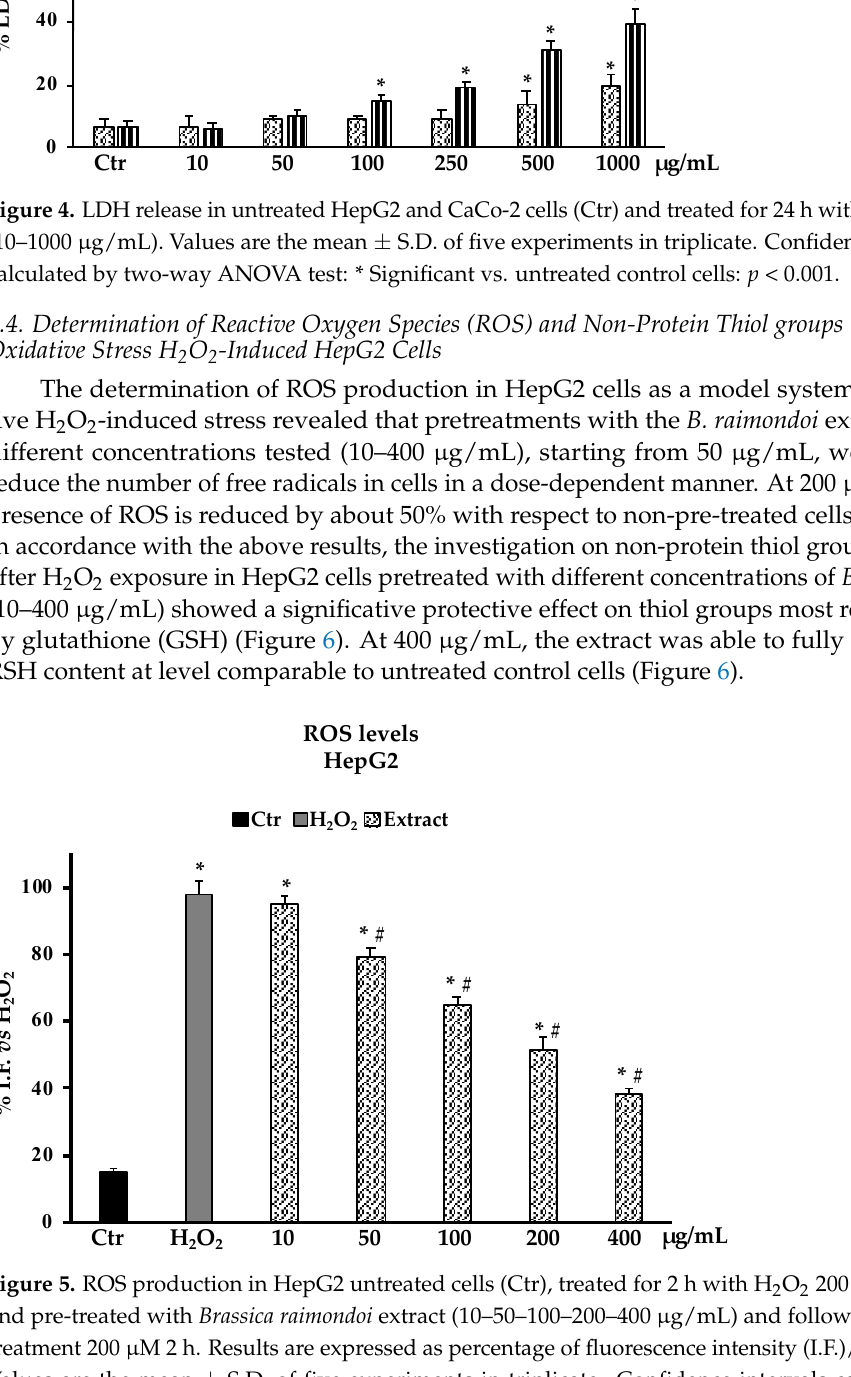
Figure 5. ROS production in HepG2 untreated cells (Ctr), treated for 2 h with H 2 O 2 200 μM (H 2 O 2 ), and pre-treated with Brassica raimondoi extract (10 – 50 – 100 – 200 –400 μg/mL) and followed by H 2 O 2 treatment 200 μM 2 h. Results are expressed as percentage of fluorescence intensity (I.F.)/mg protein. Values are the mean + S.D. of five experiments in triplicate. Confidence intervals calculated by two- way ANOVA test: * Significant vs. untreated control cells: p < 0.001; # Significant vs. H 2 O 2 treated cells: p < 0.001. I.F. vs. H 2 O 2 .: Intensity of Fluorescence vs. H 2 O 2 treated cells.